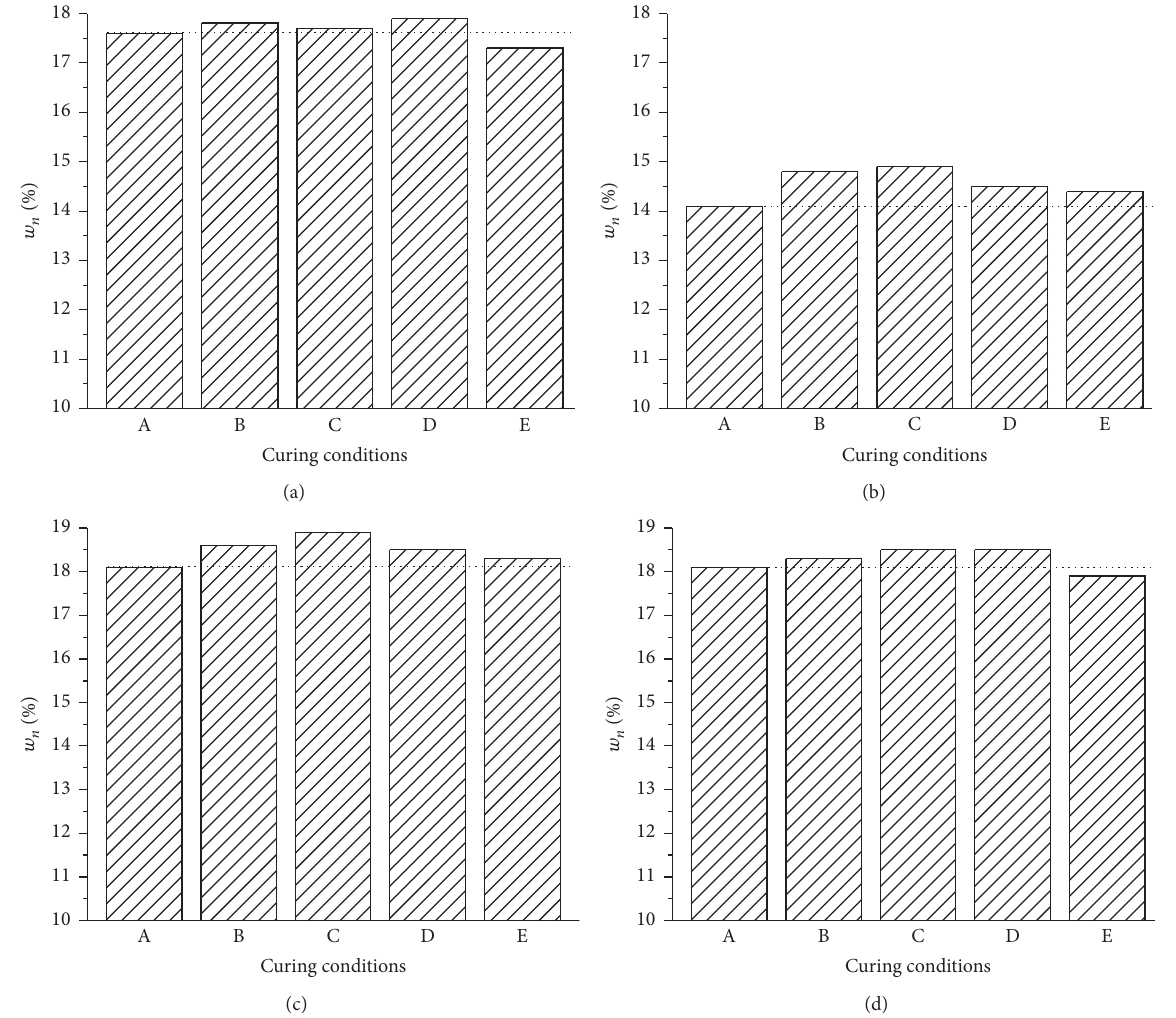
Figure 3: The 360 d nonevaporable water content of pastes under different curing conditions. Samples: (a) plain cement, (b) 45% FA, (c) 45% GGBS, and (d)12%